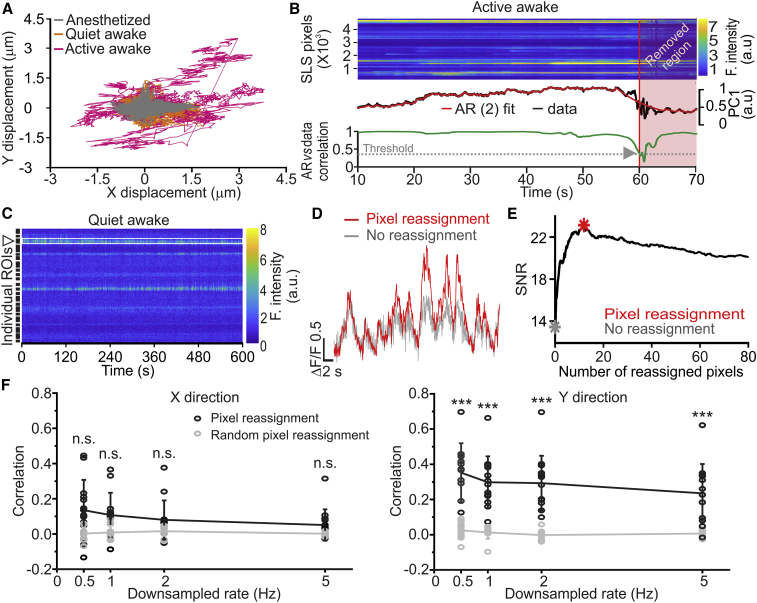
Motion Artifacts in SLS(A) X and Y displacement during raster scanning in anesthetized animals (n = 3 mice, gray), quiet wakefulness (n = 3 mice, orange), and active wakefulness (n = 3 mice, magenta).(B) Top: representative SLS acquisition during active wakefulness. Pseudocolor scale indicates fluorescence amplitude. Middle: autoregressive second order fit (AR(2), red) of SLS PC1 (black). Bottom: cross correlation (green) between AR(2) and the PC1. The gray arrowhead indicates a movement artifact detected when the 0.3 threshold is crossed.(C) Representative SLS acquisition with no detected large motion artifacts during quite wakefulness.(D) Fluorescence over time without (no reassignment, gray) or with (reassigned, red) the reassignment of 11 pixels.(E) SNR as a function of the number of reassigned pixels for one representative ROI. The gray and the red asterisks indicate the conditions displayed in (D).(F) Correlation between the motion displacement calculated using NoRMCorre on the reference patch and the motion displacement computed from the pixels reassignment approach (black dots). Empty circles: individual experiments; filled circles: average ± SD. Data from the reference patch were downsampled in time before applying NoRMCorre. Motion displacement values were separately calculated for the X (left) and the Y (right) direction in the reference patch and in the ROIs. The correlation between the motion displacement calculated using NoRMCorre and a random pixels reassignment are shown in gray. Left: downsampling 0.5 Hz, p = 0.08; downsampling 1 Hz, p = 0.18; downsampling 2 Hz, p = 0.06; downsampling 5 Hz, p = 0.32; paired t test, n = 13 SLS acquisitions. Right: downsampling 0.5, p = 2E-6; downsampling 1 Hz, p = 2E-4; downsampling 2 Hz, p = 2E-5; downsampling 5 Hz, p = 8E-9; paired t test n = 13 SLS acquisitions. In this as well in other figures: *, p < 0.05; **, p < 0.01; ***, p < 0.001; n.s., non significant. Error bars represent ± SD.